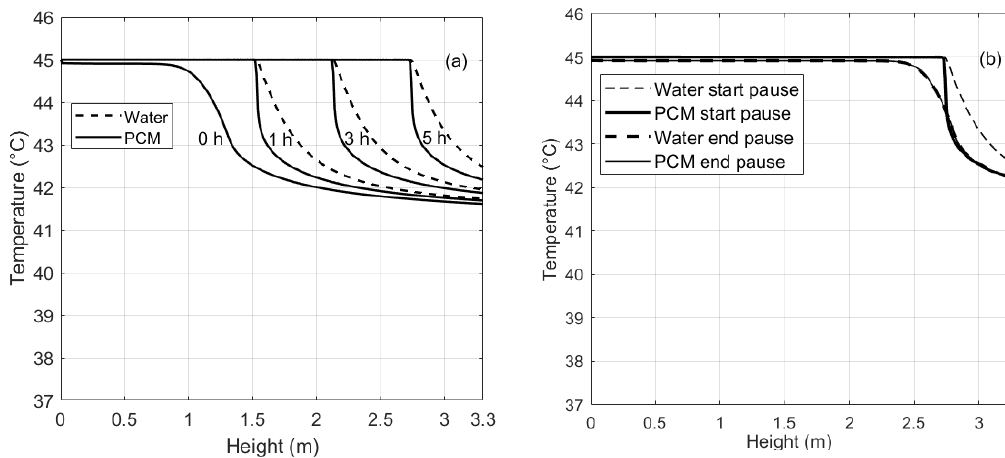
Figure 5. Evolution of the thermocline during the second charge phase ( a ) and the second idle period ( b ).